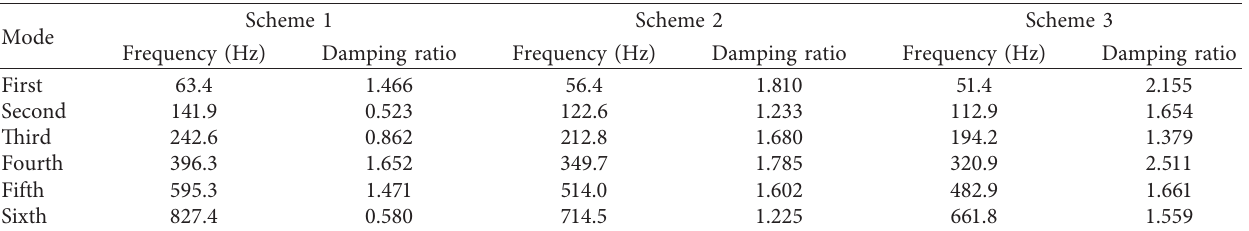
Figure 14: Location distribution of excitation and response points. Table 5: Modal frequencies and damping ratios of trapezoidal carbon strips with different damping